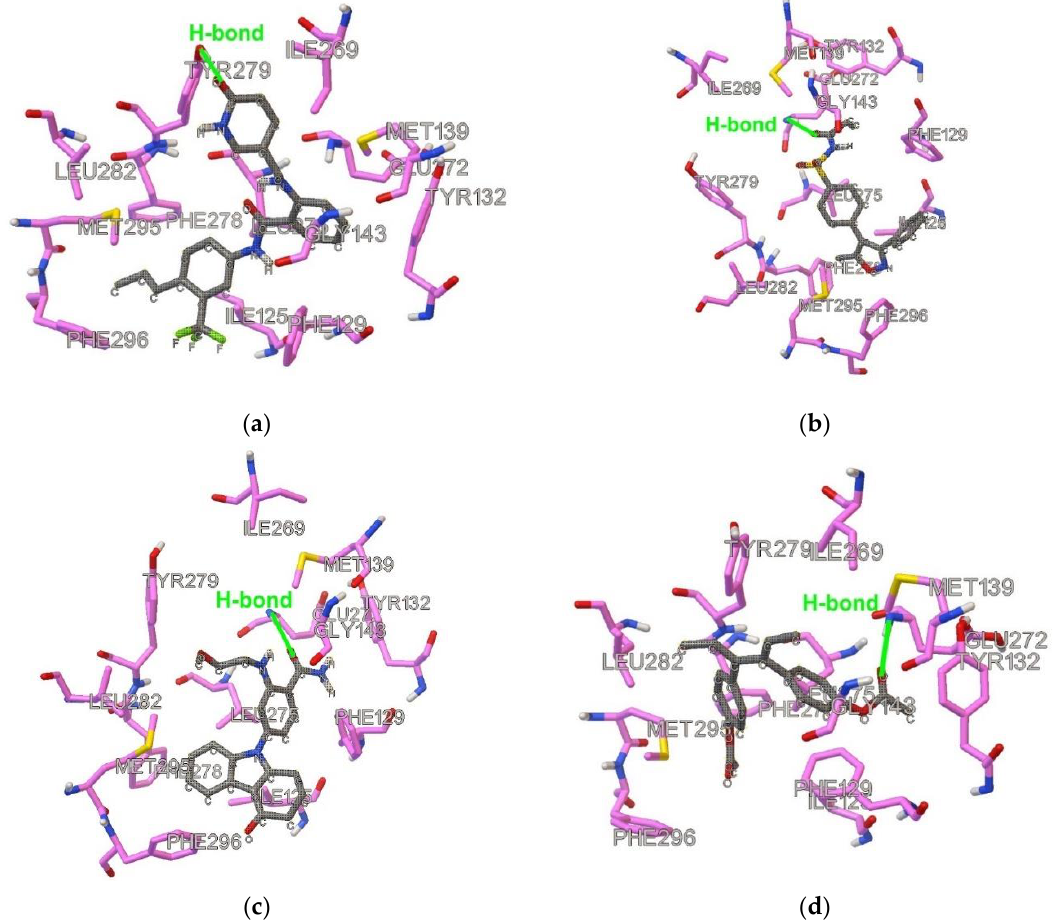
Figure 3. Docked and optimized conformation for the lead compounds: ( a ) DB07831, ( b ) DB08439, ( c ) DB08557, ( d ) DB14668. Ligand is shown with gray carbon atoms.